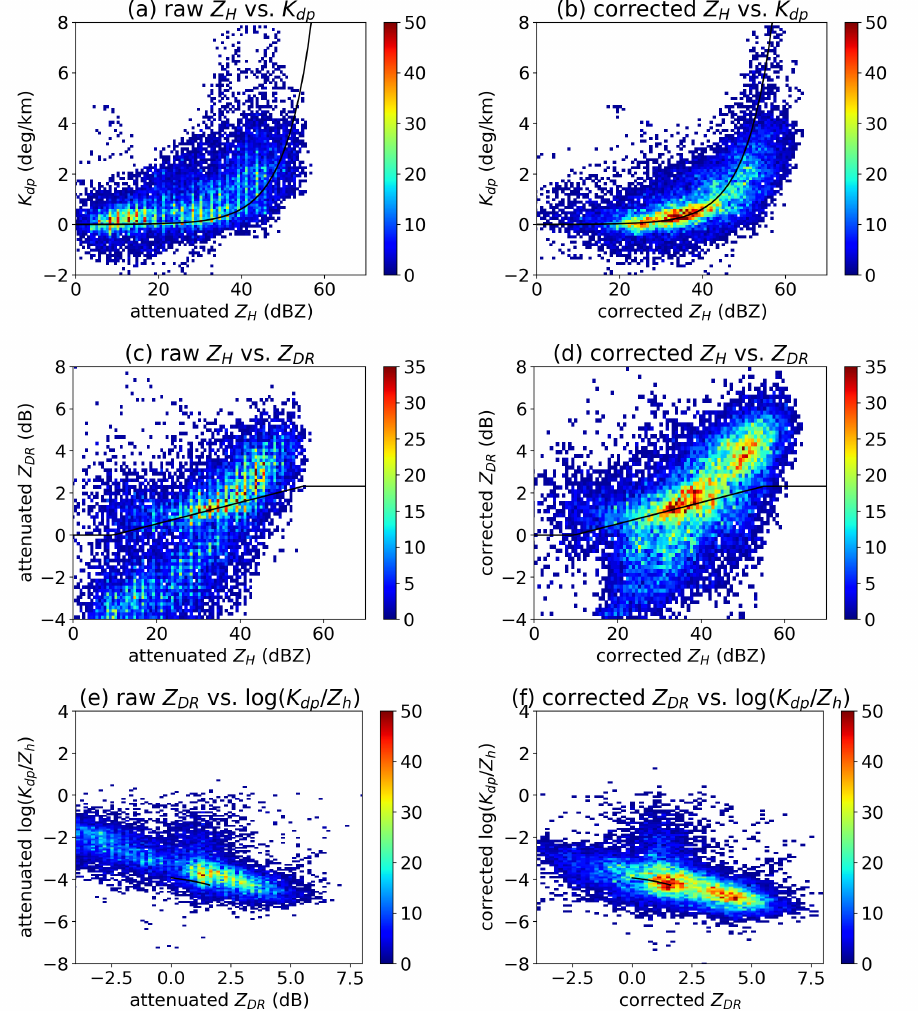
Figure 4. Scatterplots of ( a ) raw Z H and K dp , ( b ) corrected Z H and K dp , ( c ) raw Z DR and K dp , ( d ) corrected Z DR and K dp , ( e ) raw Z DR and the ratio of K dp and raw Z h , and ( f ) corrected Z DR and the ratio of K dp and corrected Z h for the data presented in Figure 3, where Z H = 10log ( Z h ) . The color scale is the number of points, and the black lines show the theoretical self-consistency